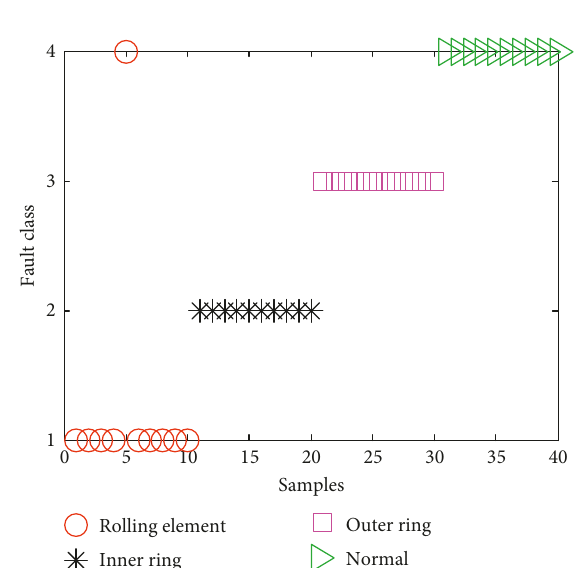
Figure 11: Classification result of bearing.